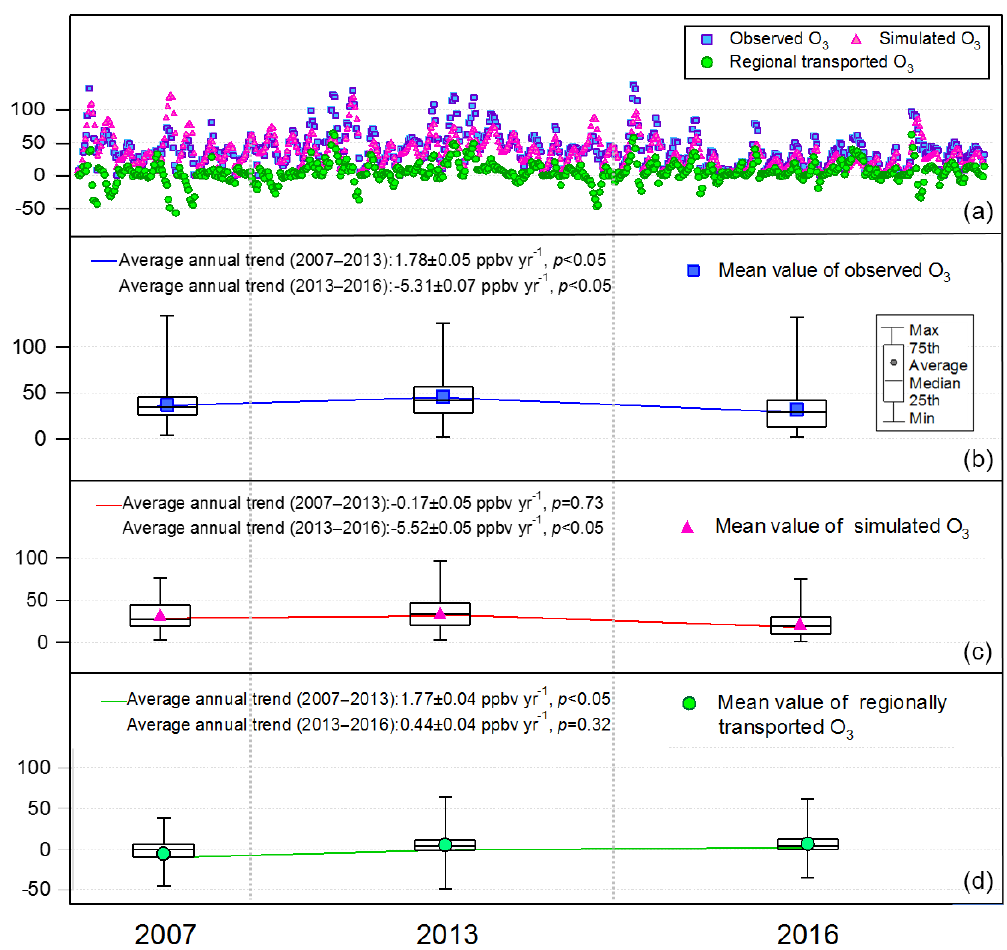
Figure 4. Hourly values (a) and the throughout-campaign statistical results (b–d) of the observed, simulated (locally produced) and regional O 3 mixing ratios in daytime hours (07:00–19:00LT) in the three sampling